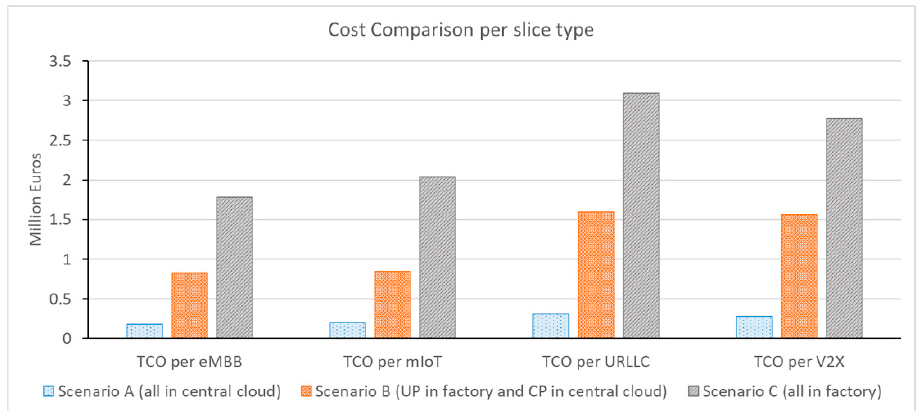
Figure 8. Cost comparison between deployment scenarios.